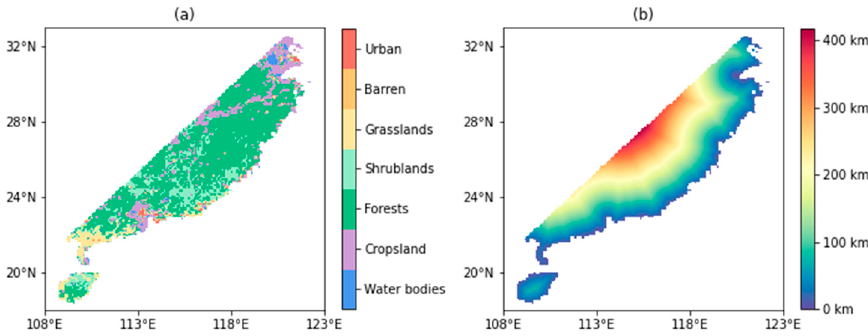
Figure 2. Surface types ( a ) and the distance to the sea ( b ) in study region.